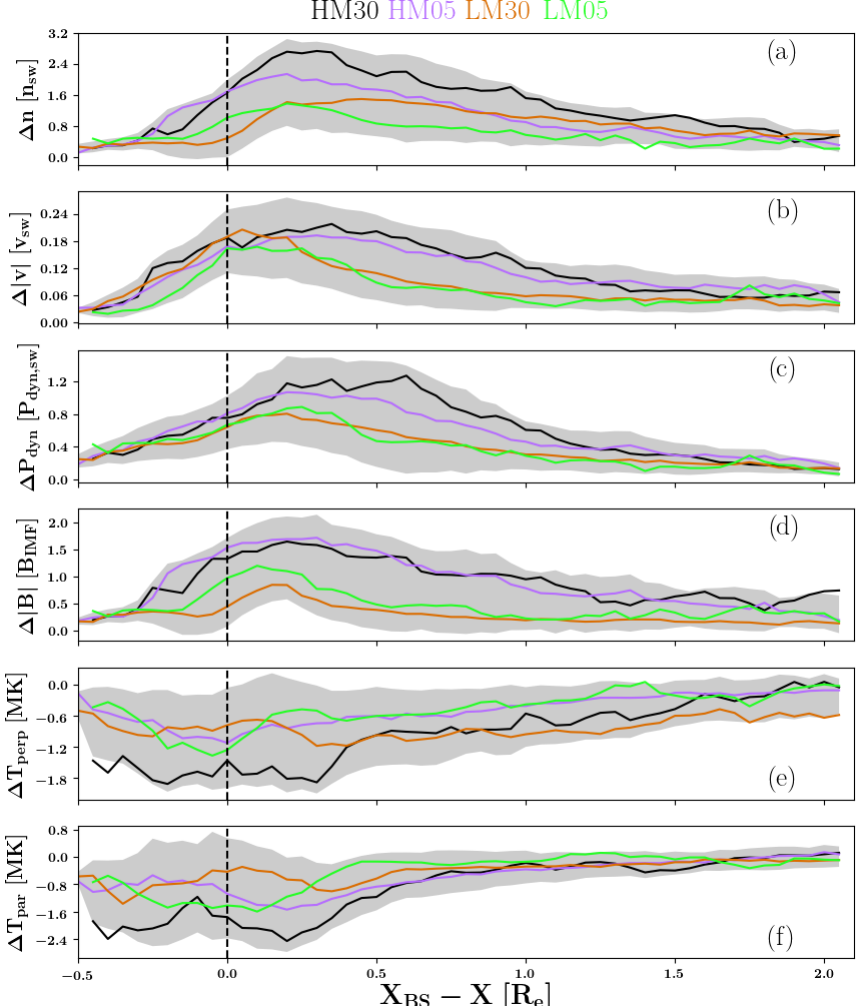
Figure 9. Superposed epoch study of the difference between the jet and magnetosheath (a) density, (b) velocity, (c) dynamic pressure, (d) magnetic field intensity, (e) perpendicular temperature, and (f) parallel temperature as a function of jet position relative to the bow shock. All other parameters are normalised to the solar wind, while the temperature data are given in megakelvins. The different colours refer to the superposed epoch averages from the different runs, identified with a run identifier (see Table 1): orange and green (black and purple) are the low (high) M A runs, respectively. Grey shows standard deviations subtracted and added to the average, taken from all